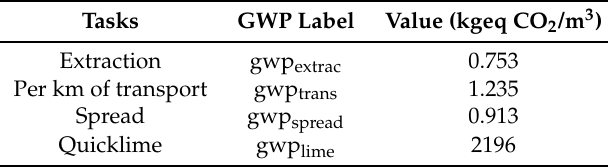
Table 1. Values of the parameters used to assess the construction phase adapted from [5].